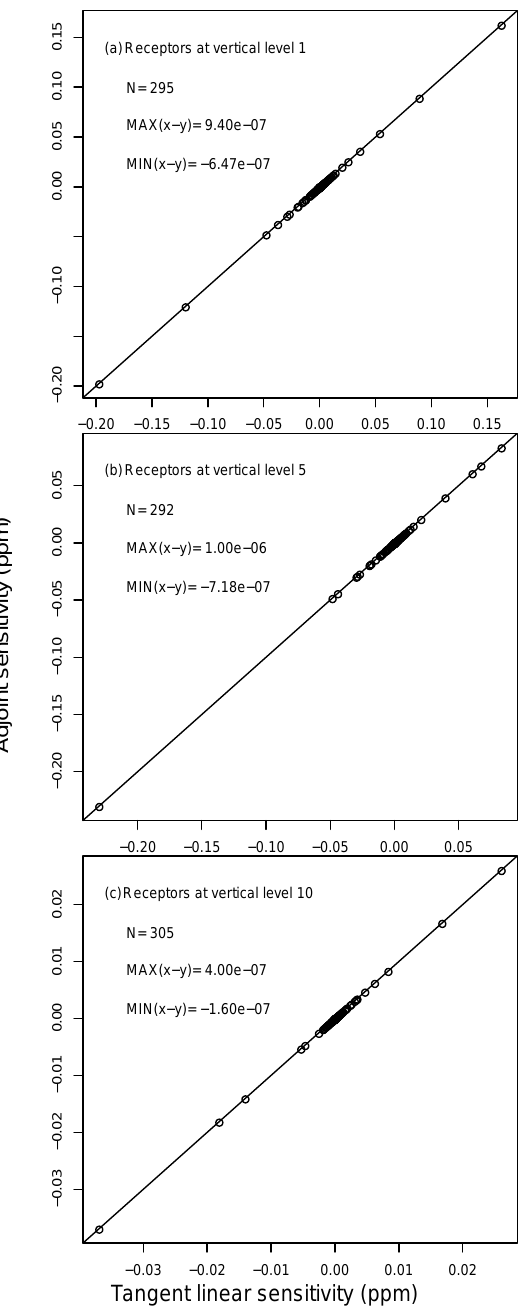
Figure 9. Comparison between ∂ q co2 /∂ k co2 calculated by the tan- gent linear ( x axis) and adjoint models ( y